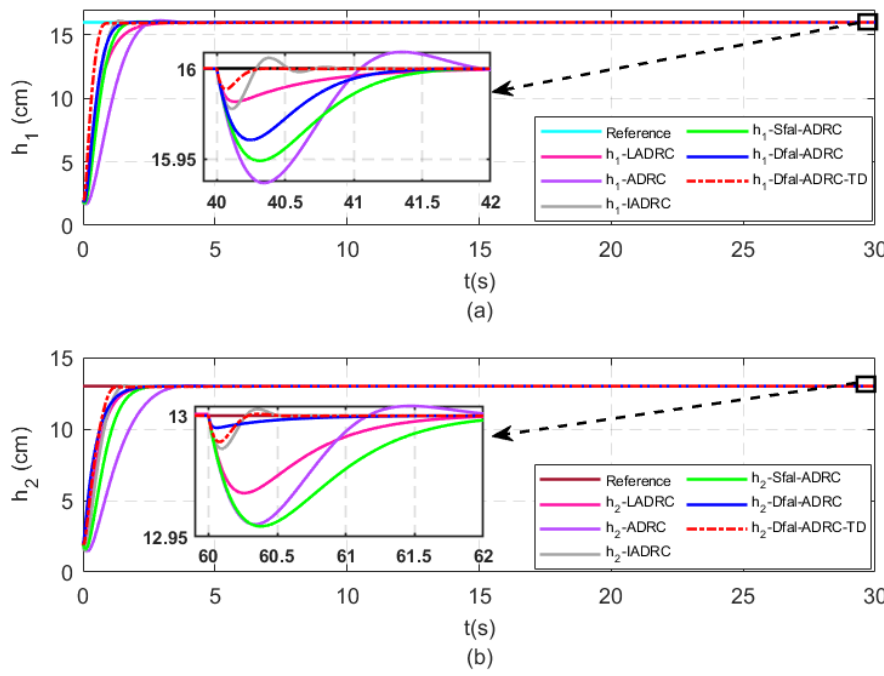
Figure 5. The water level when using the 2nd MADRC scheme. ( a ) 1st subsystem. ( b ) 2nd subsystem. Figure 6a,b show the control signal of the first subsystem and the second subsystem respectively. It is observed that the first MADRC scheme (i.e., STC-ADRC) is chattering-free with a smooth response; moreover, the NLPD-ADRC shows a reduction in chattering,